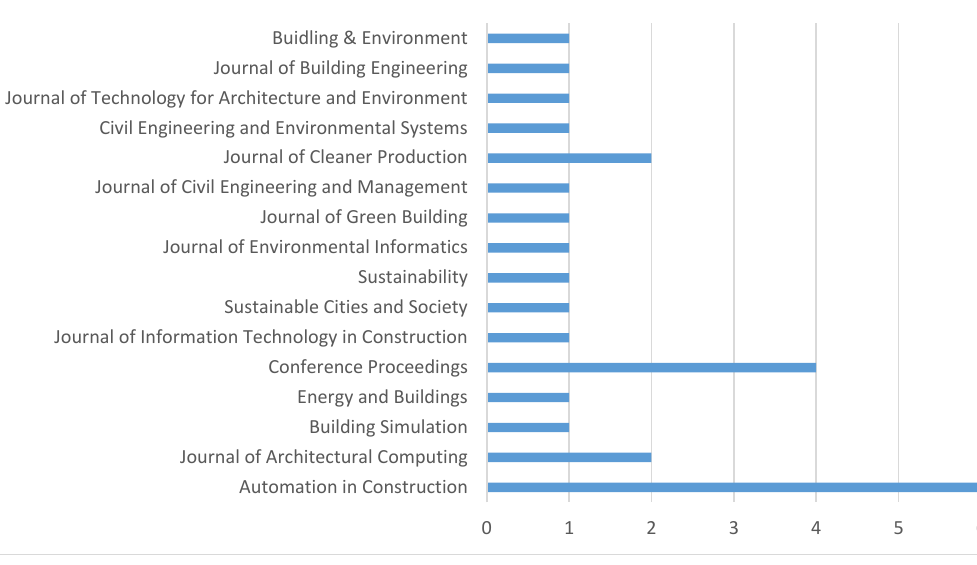
Figure 10. Commonly assessed categories (BREEAM and LEED).